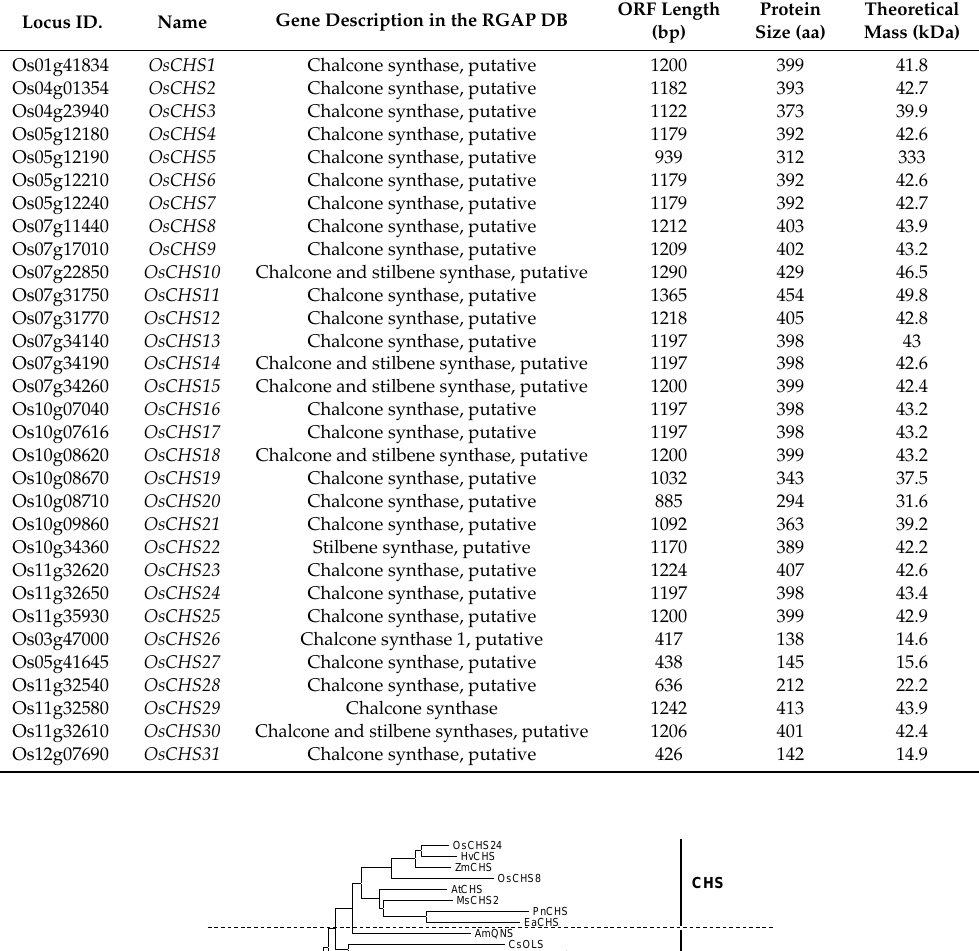
Table 1. Rice CHS family. The MSU RGAP Database search revealed 31 genes that were annotated as putative CHSs and / or STSs, which comprise the CHS family in rice. Locus ID.